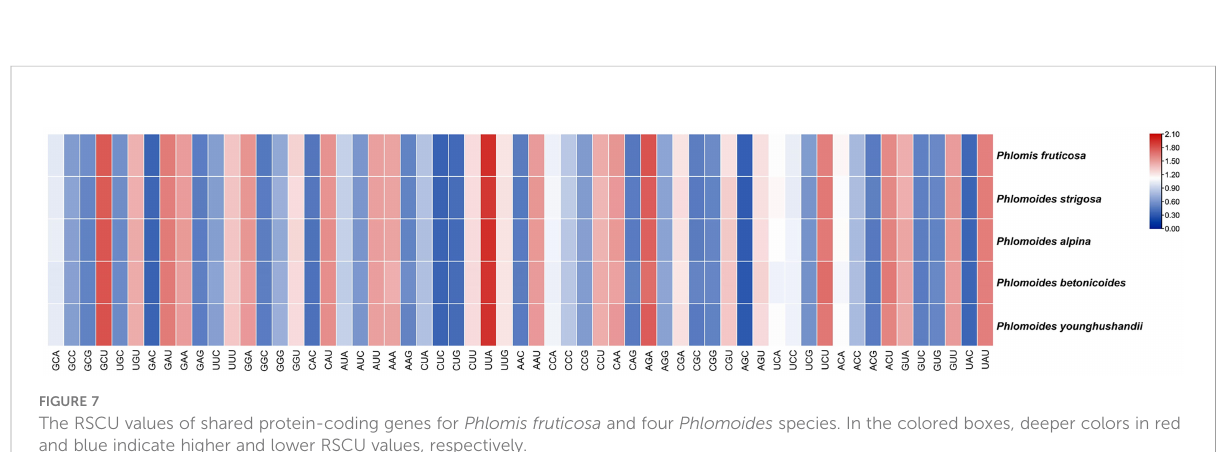
FIGURE 7 The RSCU values of shared protein-coding genes for Phlomis fruticosa and four Phlomoides species. In the colored boxes, deeper colors in red and blue indicate higher and lower RSCU values,